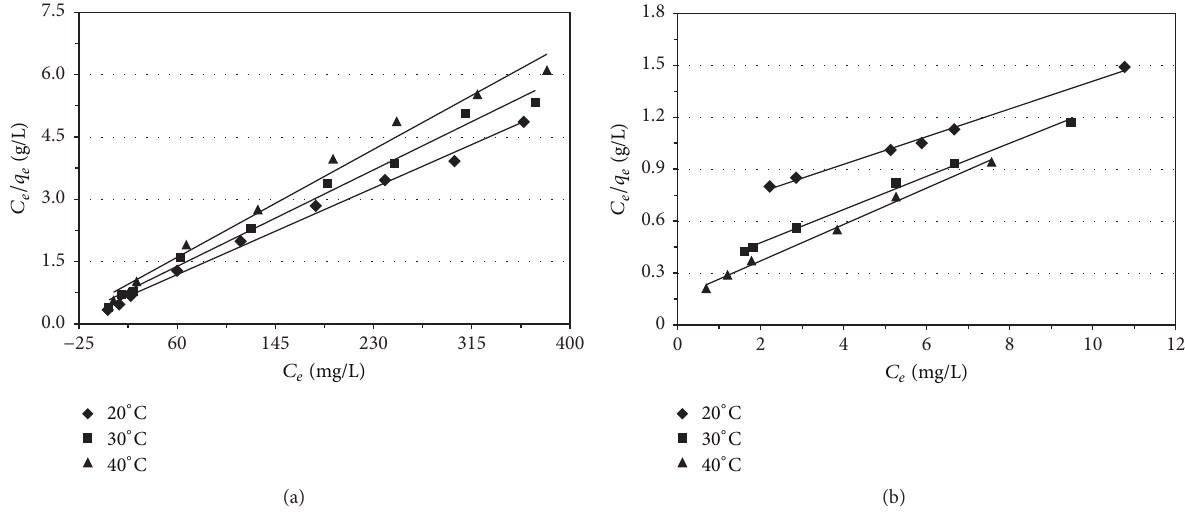
Figure 7: Langmuir isotherm of LDPO-G for fluoride and phosphate removal. (a) Removal of phosphate at 20, 30, and 40 ∘ C. (b) Removal of fluoride at 20, 30, and 40 ∘ C.